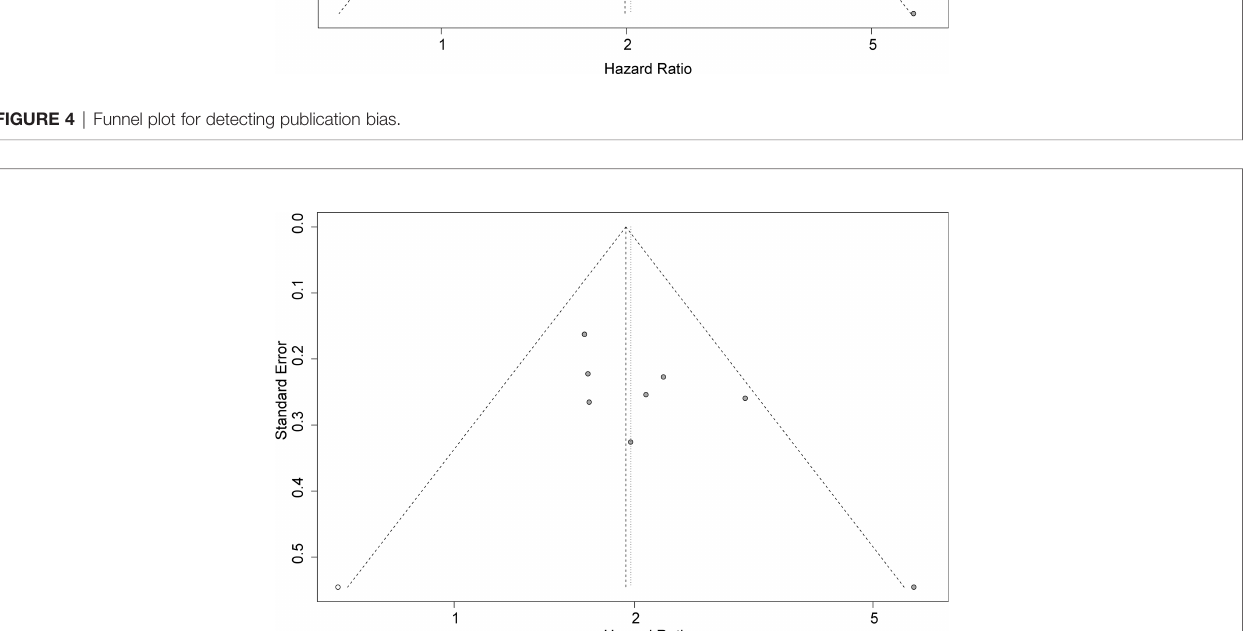
FIGURE 5 | Funnel plot after a trim-and- fi ll